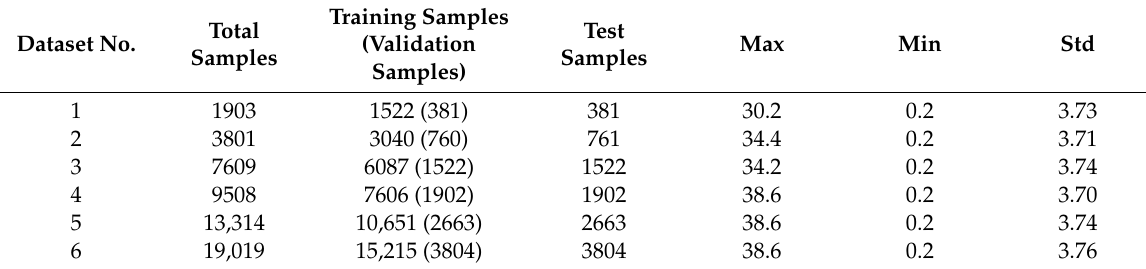
Table 5. Description of the datasets with di ff erent